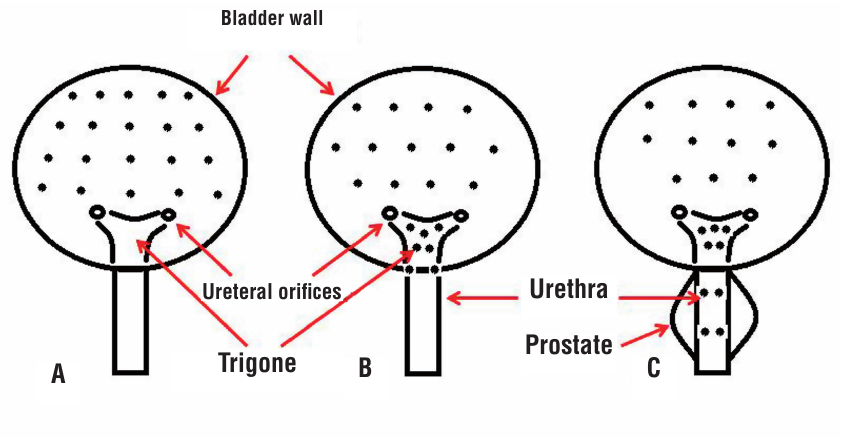
figure 1 - schematic diagram for sites of botulinum toxin A injection: A) Group B patients, male or female (20 detrusor only injections); B) Group A patients, female (13 injections into detrusor, 5 trigone injection and 2 bladder neck injections at 5 and 7 o’clock positions); c) Group A patients, male (11 detrusor injection, 5 trigone injections, and 4 injections in the proximal and distal prostatic urethra at 3 and 9 o’clock